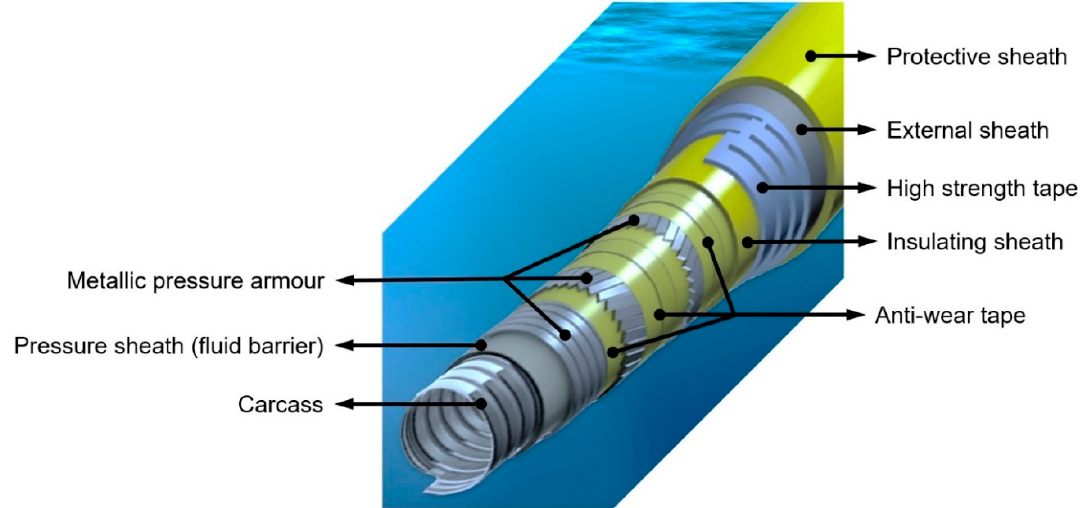
Figure 1. Schematic of a typical flexible umbilical cable for offshore engineering.